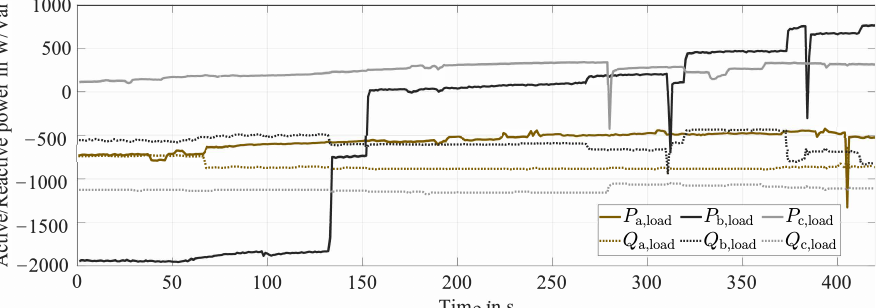
Figure 21. Active and reactive phase loads. Simulation results are shown in Figure 22, which depicts the measured voltage magni- tudes at the transformer (brown/black/grey, dotted) and measuring point (brown/black/grey, solid), as well as the results of the simulation (blue), separated by phase. We can state that measured voltages V i n,load,meas and simulated voltages V i n,load,sim correlate quite well. This is visible and valid particularly for events of heavy load shifts, as the sudden changes of voltages are reproduced by our simulation model—even in cases, where the load change is applied on another phase. However, in all curves, an offset between measurement results and simulated voltages is visible, which depends on the momentary load level and load